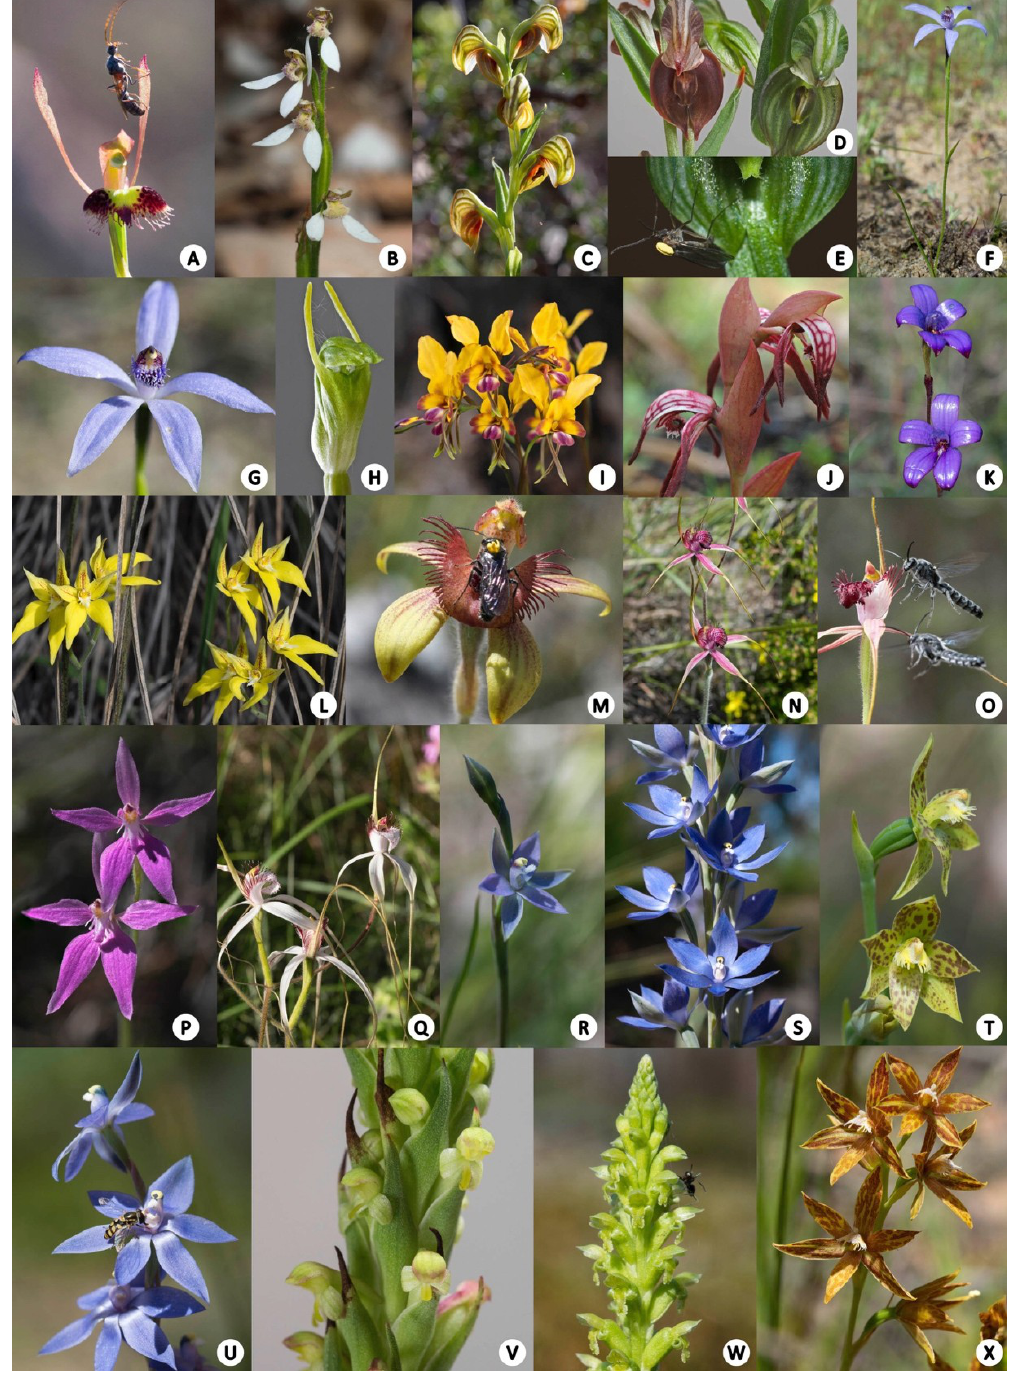
Figure 1. Photographs showing differences in the form and color of flowers of 20 orchid species with some associated insects; ( A ) Leporella fimbria with male bull ant ( Myrmecia sp.); ( B ) Eriochilus dilatatus . ( CDE ) Pterostylis sanguinea . ( D ) red and green color forms of this species co-occur; ( E ) Fungus gnat with pollinia ( Mycomya sp.); ( FG ) Pheladenia deformis; ( H ) Pterostylis ectypha; ( I) Diuris magnifica ; ( J ) Pyrorchis nigricans ; ( K ) Elythranthera brunonis ; ( L ) Caladenia flava ; ( M ) Caladenia discoidea flower and male thynnine wasp with attached pollen ( Phymatothynnus sp.); ( NO ) Caladenia arenicola ; ( O ) Male thynnine wasps competing for a C. arenicola flower ( Zaspilothynnus sp.); ( P ) Caladenia latifolia ; ( Q ) Caladenia longicauda subsp. calcigena ; ( R ) Thelymitra vulgaris ; ( S) Thelymitra macrophylla ; ( T ) Thelymitra benthamiana ; ( U ) Thelymitra graminea with hoverfly; ( V ) Disa bracteata ; ( W ) Microtis media ; ( X ) Thelymitra fuscolutea .